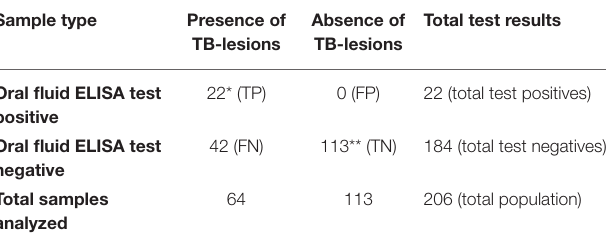
Frontiers in Veterinary Science |